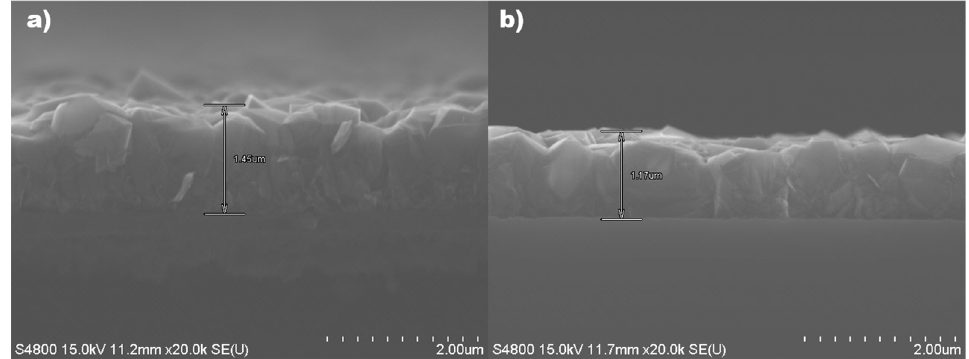
Figure 6. Cross ‐ section morphologies of the diamond film deposited at applied powers of ( a ) 16 kW and ( b ) 18 kW.